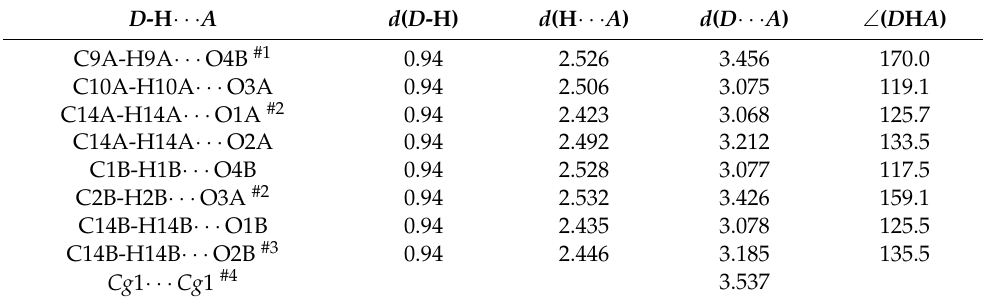
Table 1. Non-covalent intermolecular interactions in compound ( 1a ) (Å and ◦ ).